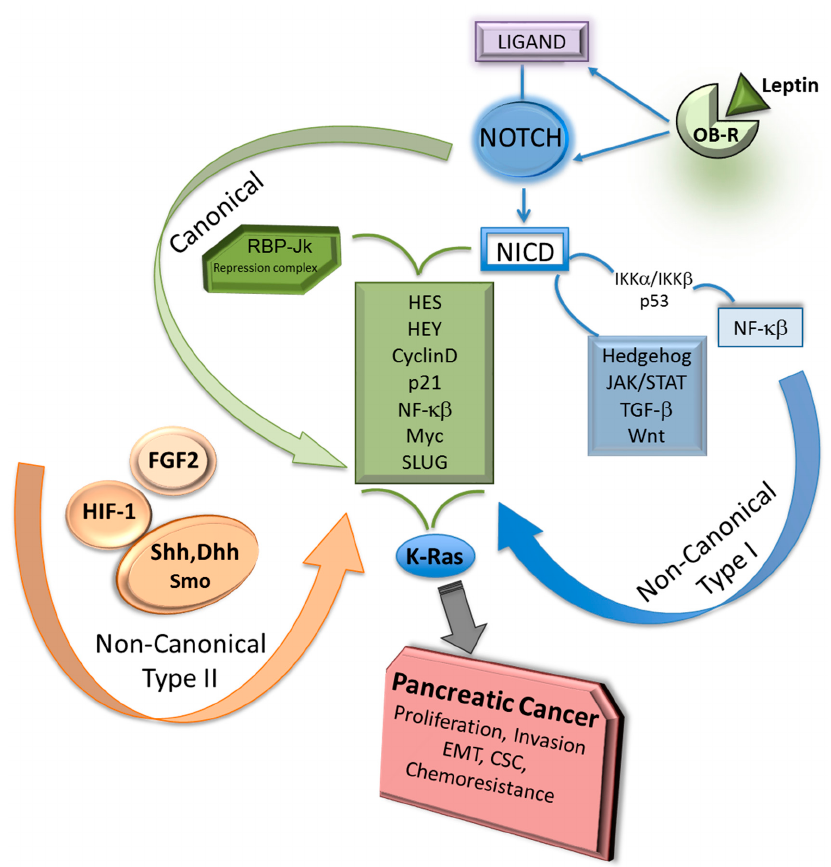
Figure 2. Notch canonical and non-canonical signaling pathways and PC. Notch canonical signals require the activation of membrane-bound Notch receptors via ligand binding and production of Notch intracellular domain (NICD), which binds to RBP-Jk repressor complex to induce transcription of Notch targets (Hes, Hey, Cyclin D, etc.) [4,5,18,20,22]. Notch non-canonical Type I signals require NICD involvement to activate NF- κ B, Hedgehog, JAK/STAT. TGF- β or Wnt. In contrast, Notch non-canonical Type II signals triggered by diverse factors (i.e., FGF2, HIF-1 α , Hedgehog) do not require NICD or RBP-Jk involvement [30–36]. Notch and KRAS activation show synergic effects to